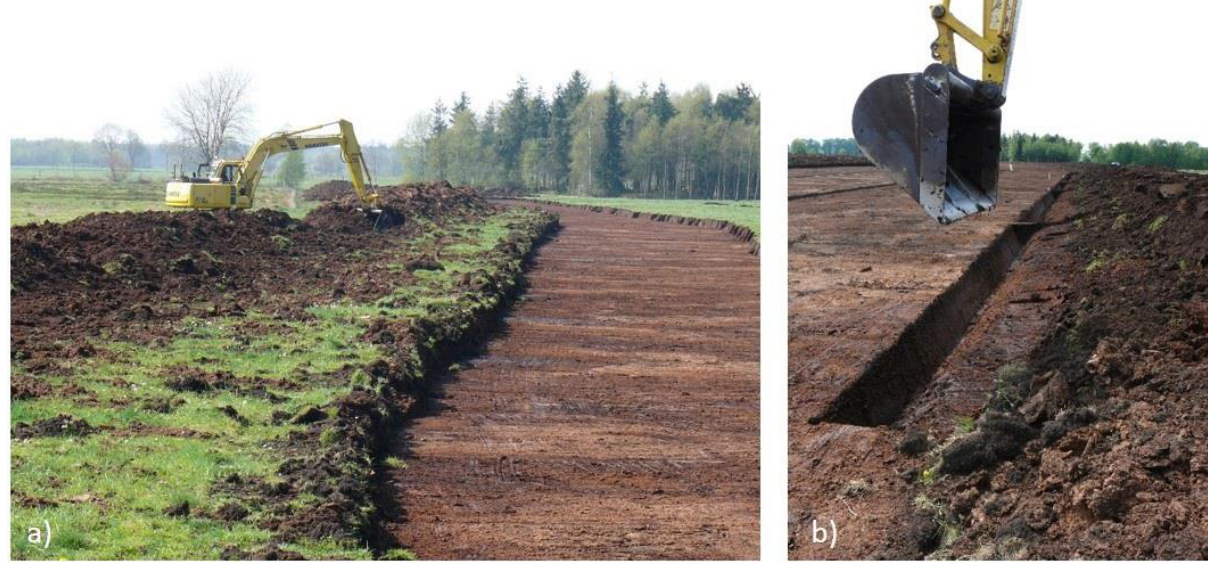
Figure 3. Setting up a Sphagnum farming site on former bog grassland in Germany (Rastede), using an excavator for a) removal of the degraded topsoil and b) construction of causeways and irrigation ditches. Photos: Sabine